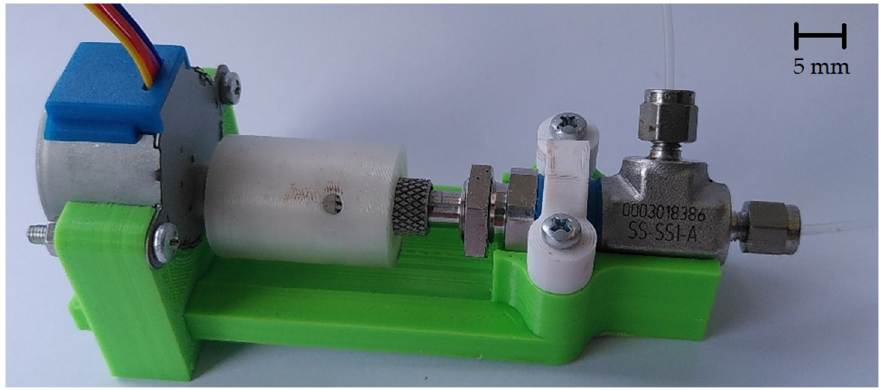
Figure 13 . Needle valve with 3D-printed modification to allow operation using a stepper motor. Figure 13. Needle valve with 3D-printed modification to allow operation using a stepper